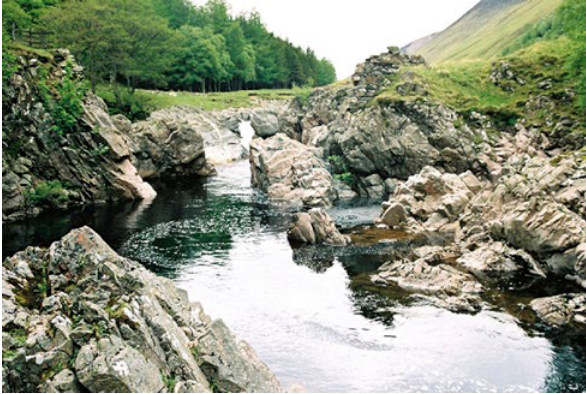
Figure 26. This is the location of Hutton’s observations of intrusive granite, Glen Tilt, Scottish Highlands (from Wikipedia).